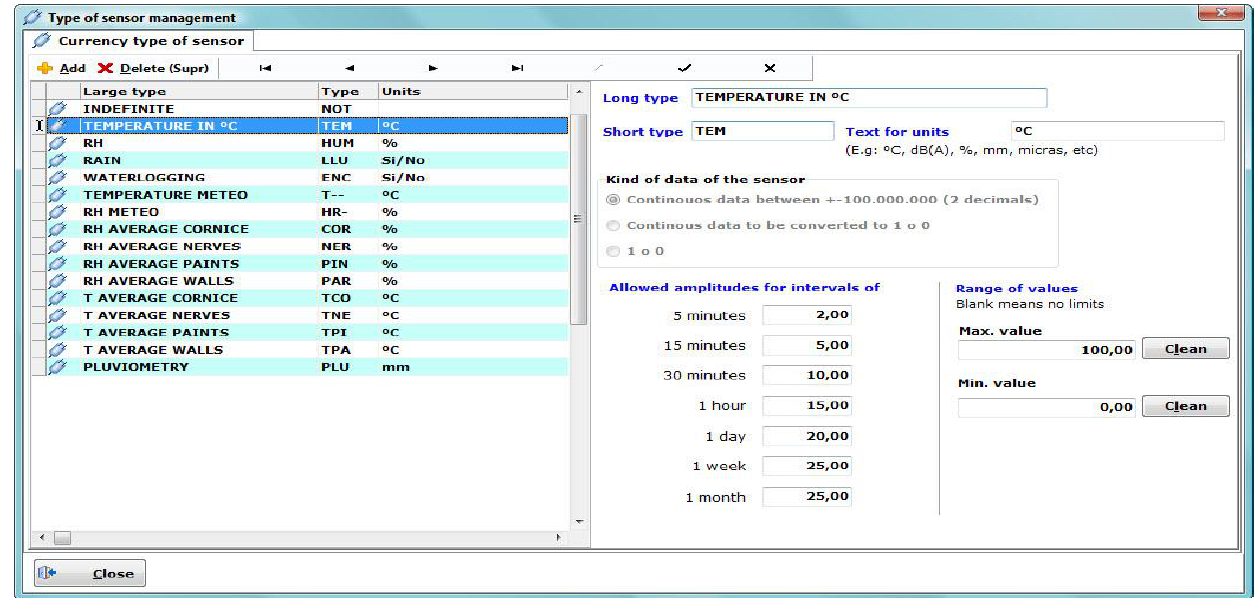
Figure 3. Type of sensor management